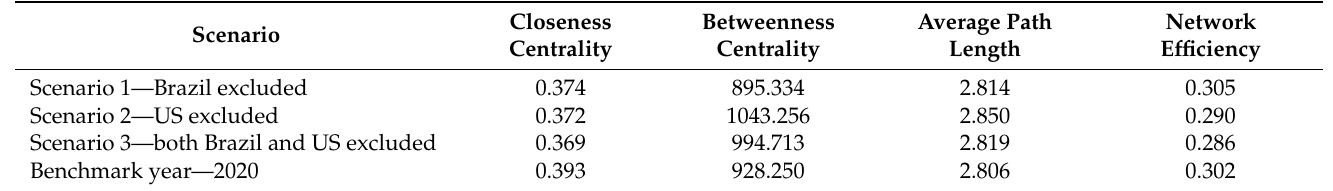
Table 3. Basic topological properties of the GSTN after targeted destruction (data source: results from this